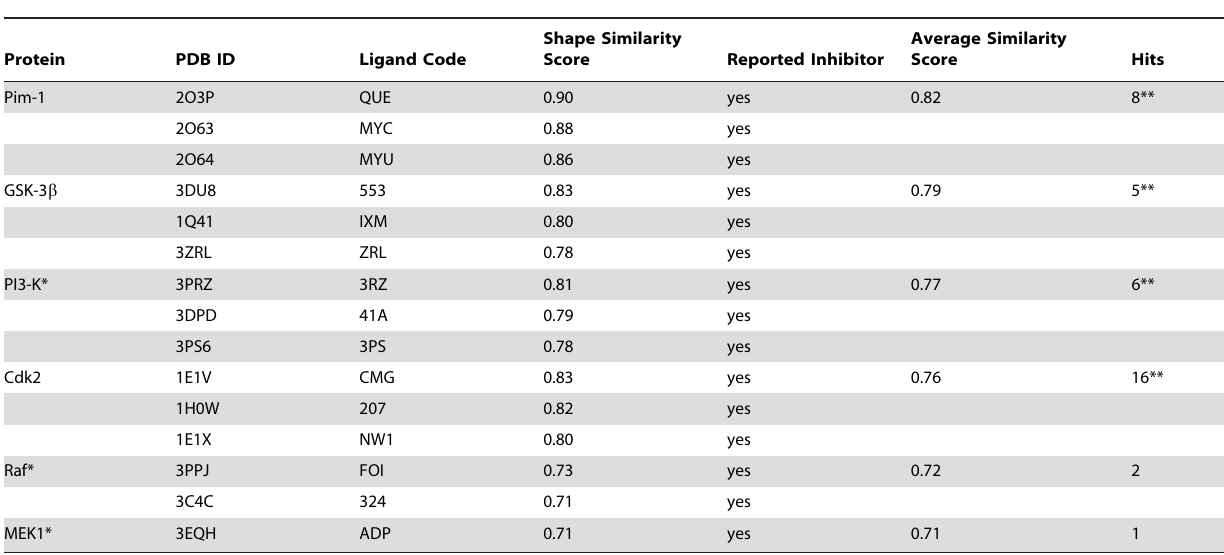
Table 2. Potential kinase targets of myricetin.